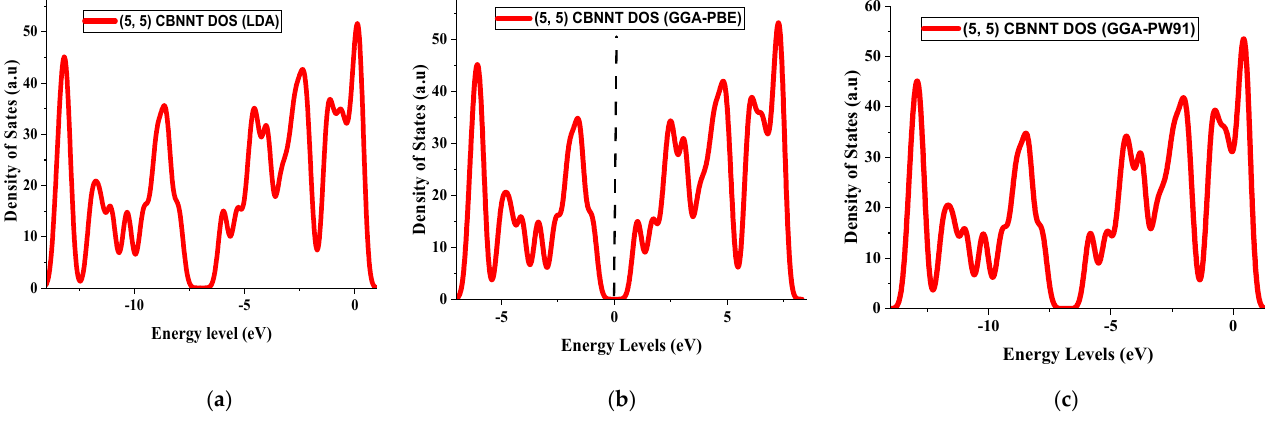
Table 3. The effect of exchange-correlation in the Fermi energy. Figure 3. TDOS for (5, 5) CBNNT systems under three different exchange-correlations of LDA and GGA. ( a ) Effect of LDA; ( b ) effect of PBE; ( c ) effect of PW91.